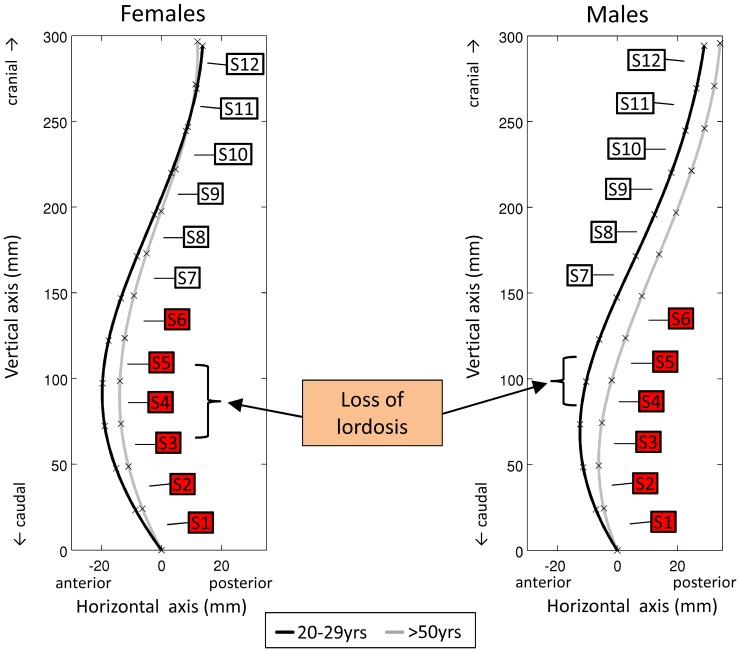
Age-related postural adaptations of the 12 Epionics segments between the oldest and youngest age cohorts for females (left) and males (right).